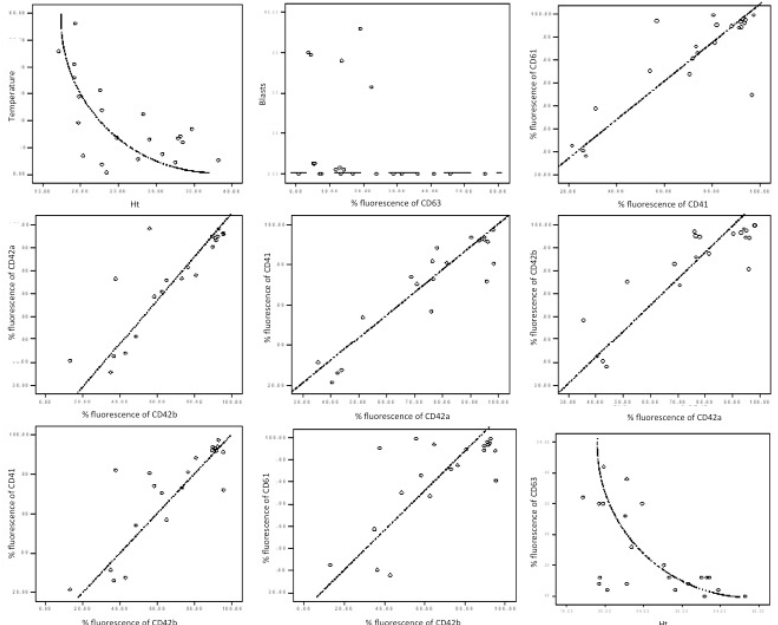
Figure 3. Graphical correlation in AML patients. Each box illustrates the statistic results presented in Table 3. There are represented correlations between temperature and haematocrit (Ht)—non-linear inverted correlation; CD63 and blasts—no correlation; CD41 and CD61—direct correlation; CD42a and CD42b—direct correlation; CD42a and CD41—direct correlation; CD42b and CD42a—direct correlation; CD42b and CD41—direct correlation; CD42b and CD61—direct correlation; Ht and CD61—inverted correlation.